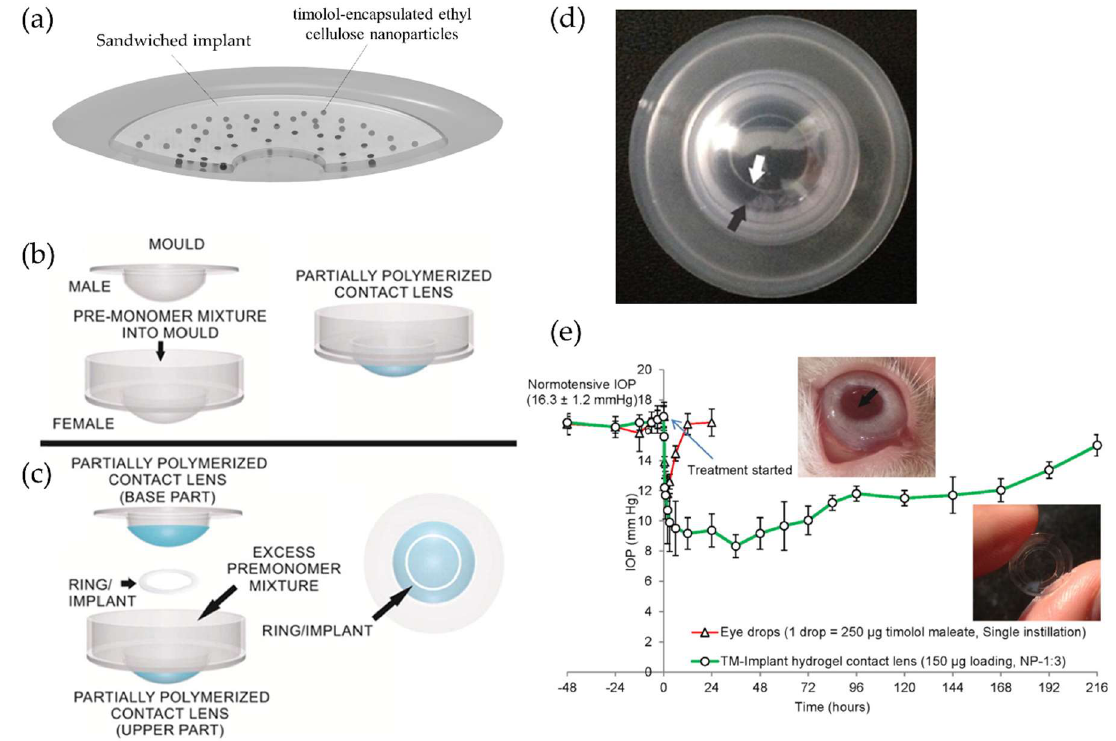
Figure 6. ( a ) Schematic of therapeutic contact lenses embedded with a sandwiched polymeric implant with timolol-encapsulated ethyl cellulose nanoparticles; schematic showing the process of fabricating contact lenses by ( b ) fabrication of partially UV-polymerized contact lenses and then ( c ) implantation of a ring implant between partially polymerized contact lenses; ( d ) Photograph of implant-embedded contact lens on a male mold showing a clear 6 mm central aperture and a translucent ring (White arrow: inner margin of the implant, black arrow: outer margin of the implant); ( e ) Change in intraocular pressure (IOP) in rabbits treated with eye drop and timolol-laden implant-embedded contact lens. Reprinted with permission from [62].